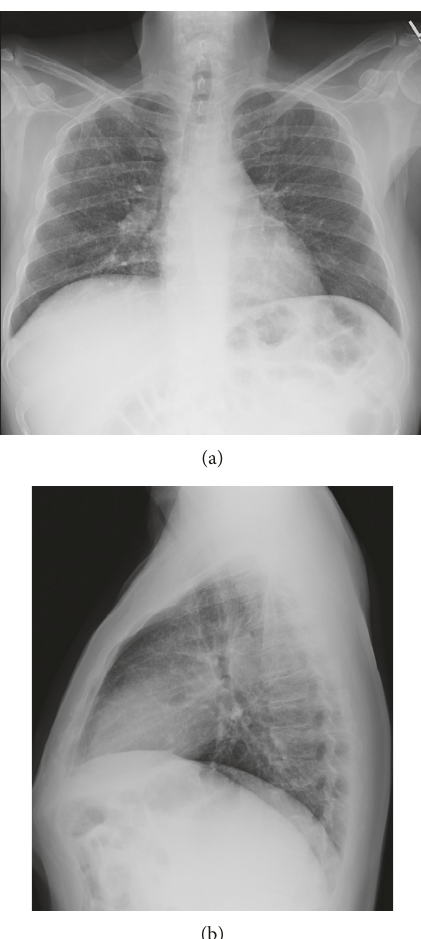
Figure 5: Chest roentgenogram four months after hospitalization. (a) PA and (b) lateral chest radiographs post treatment four months later demonstrated marked